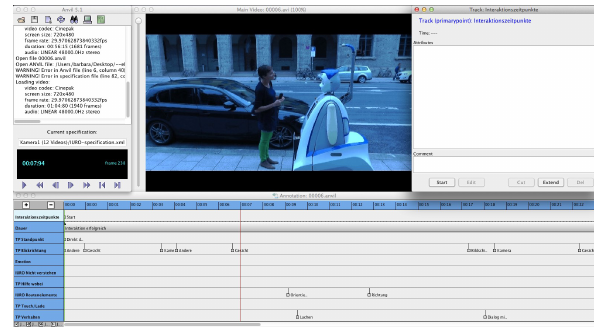
Figure 5: Video annotation in